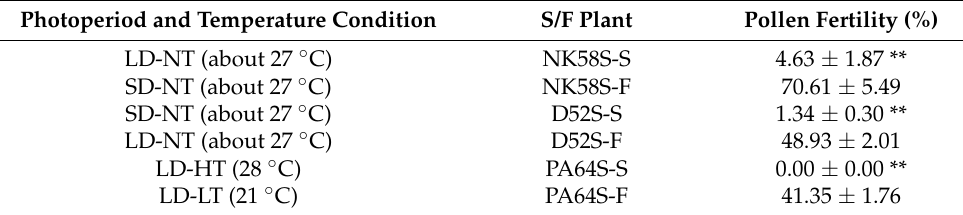
Table 1. Pollen fertility of PA64S, D52S and NK58S by photoperiod and temperature treatment. Photoperiod and Temperature